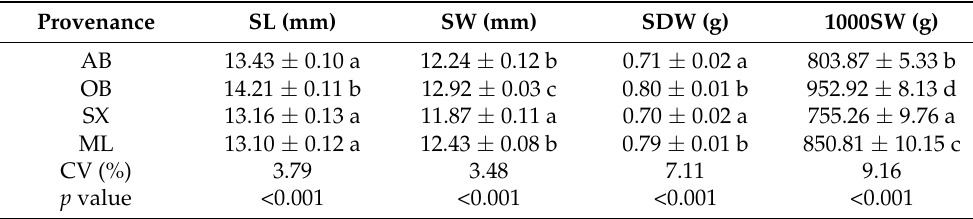
Table 2. Variation in seed morphological parameters among four X. sorbifolium provenances. Provenance